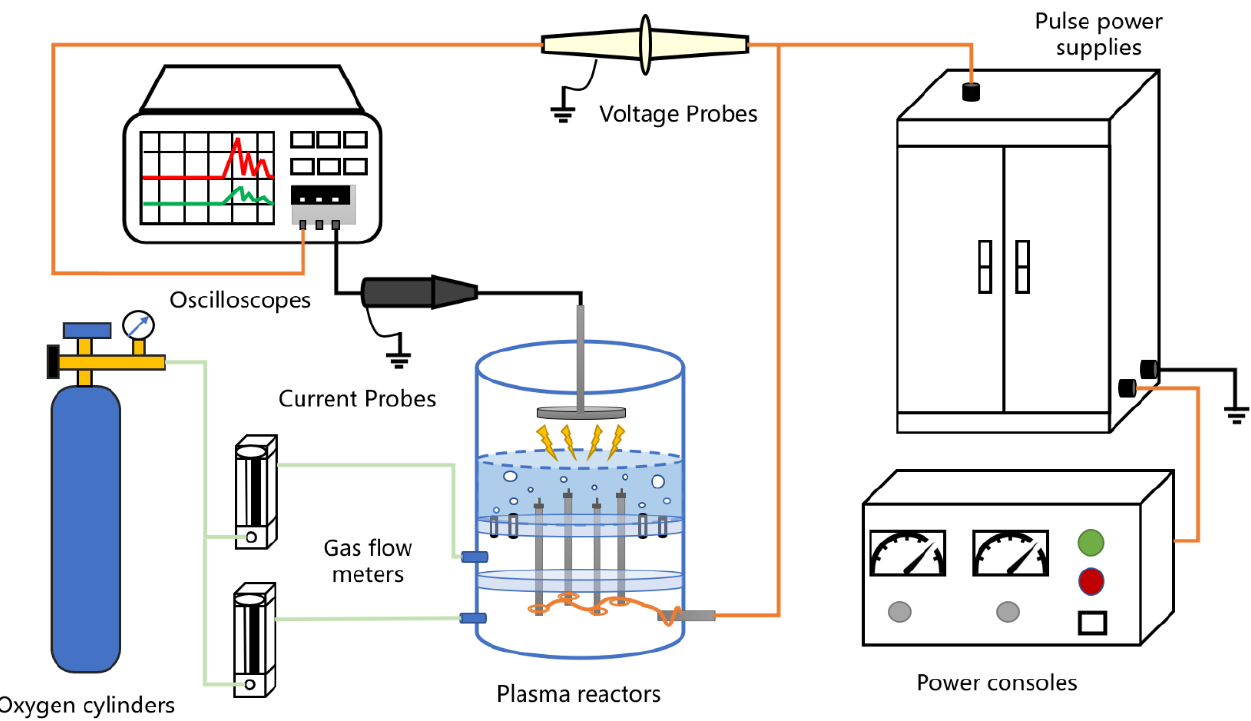
Figure 12. Schematic diagram of the experimental setup.